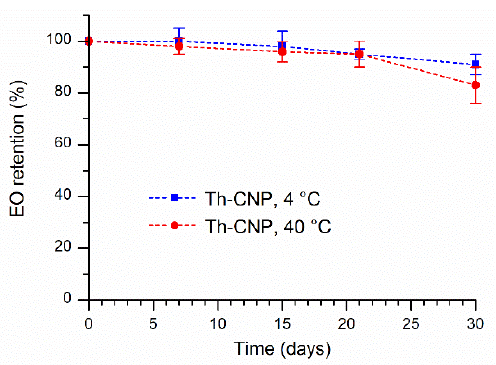
Figure 4. Essential oil retention over time at 4 °C (square) and 40 °C (circle) for Th-CNPs. Unexpectedly, Or-CNPs shows a recognizably different phenomenon. After 7 days of storage at 4 °C temperature, the EO content in nanoparticles was almost unchanged, while the Or-CNPs sample kept at 40 °C showed only 52% of EO retention. Successively, decreas- ing trend in the content of oregano essential oil into nanoparticles was observed, reaching, at 30 days, retention values of 71% and 31% at 4 °C and 40 °C, respectively (Figure 5).